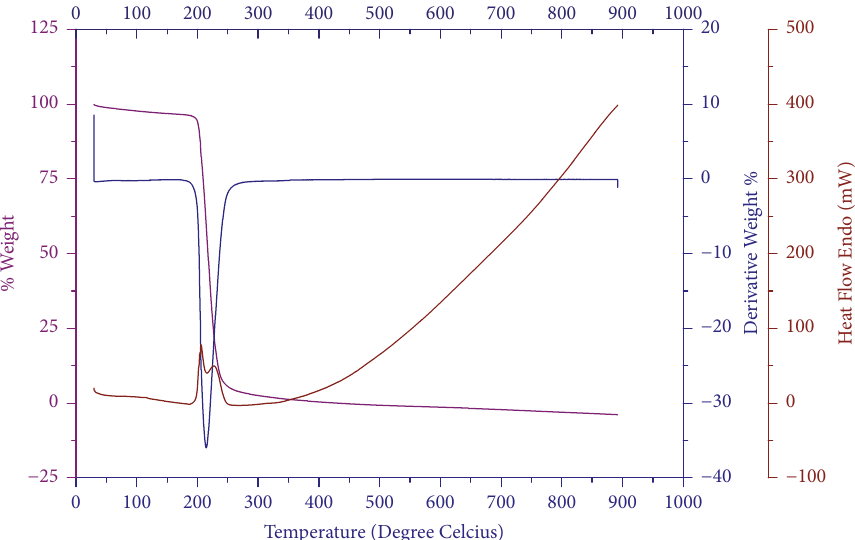
Figure 10: Thermal analysis of IMLT